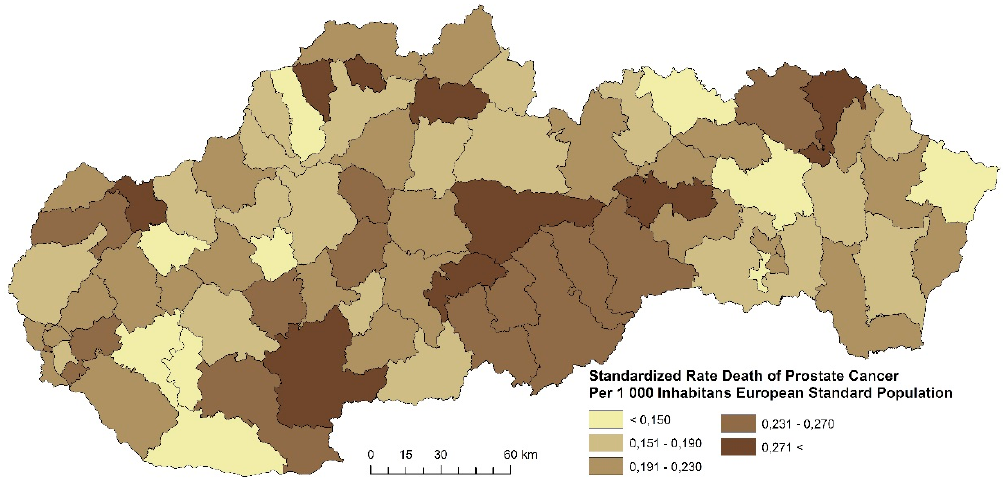
Figure 19. Standardized death rate of prostate cancer per 1000 inhabitants of European Standard Population, 2013–2018. Source: Statistical Office of the Slovak Republic, 2019.